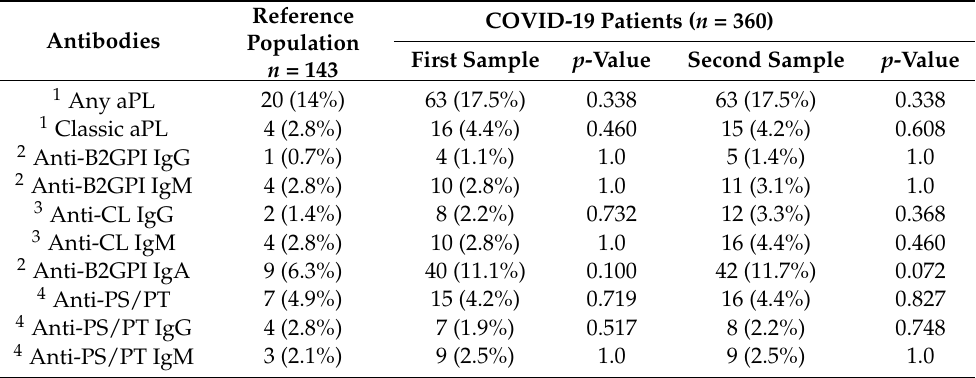
1 aPL, antiphospholipid antibody. 2 B2GPI, β 2-glycoprotein-I. 3 CL, cardiolipin. 4 PS/PT,